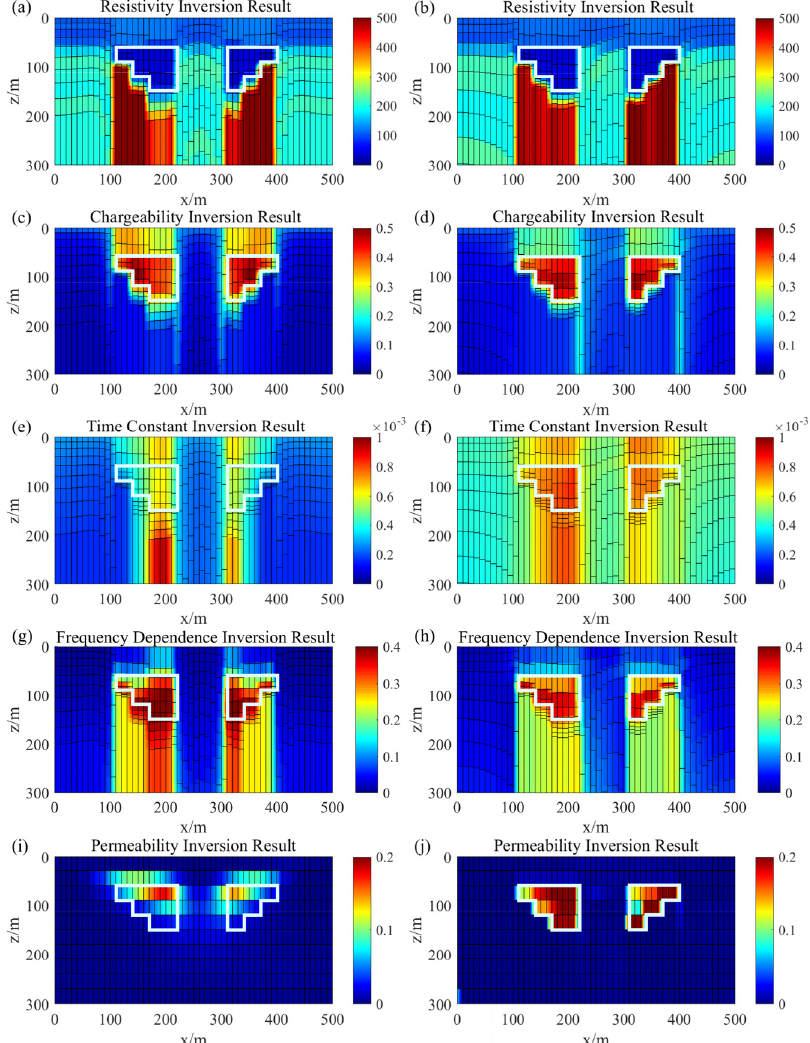
Figure 10. Comparison between the conventional inversion and cooperative inversion results of model 1: ( a , c , e , g , i ) conventional inversion results; ( b , d , f , h , j ) cooperative inversion results.